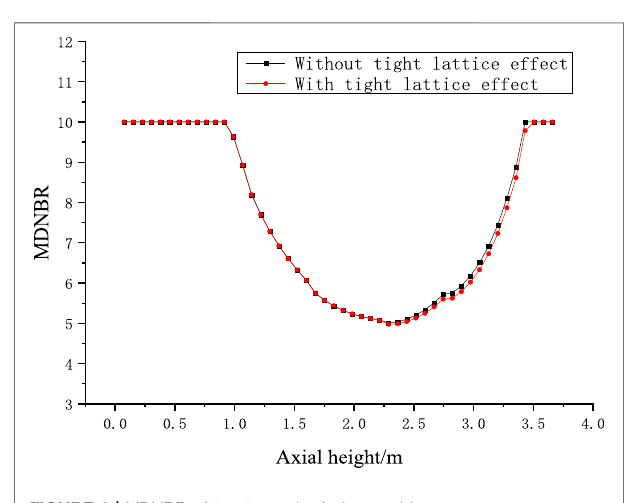
FIGURE 8 | MDNBR of 5 × 5 annular fuel